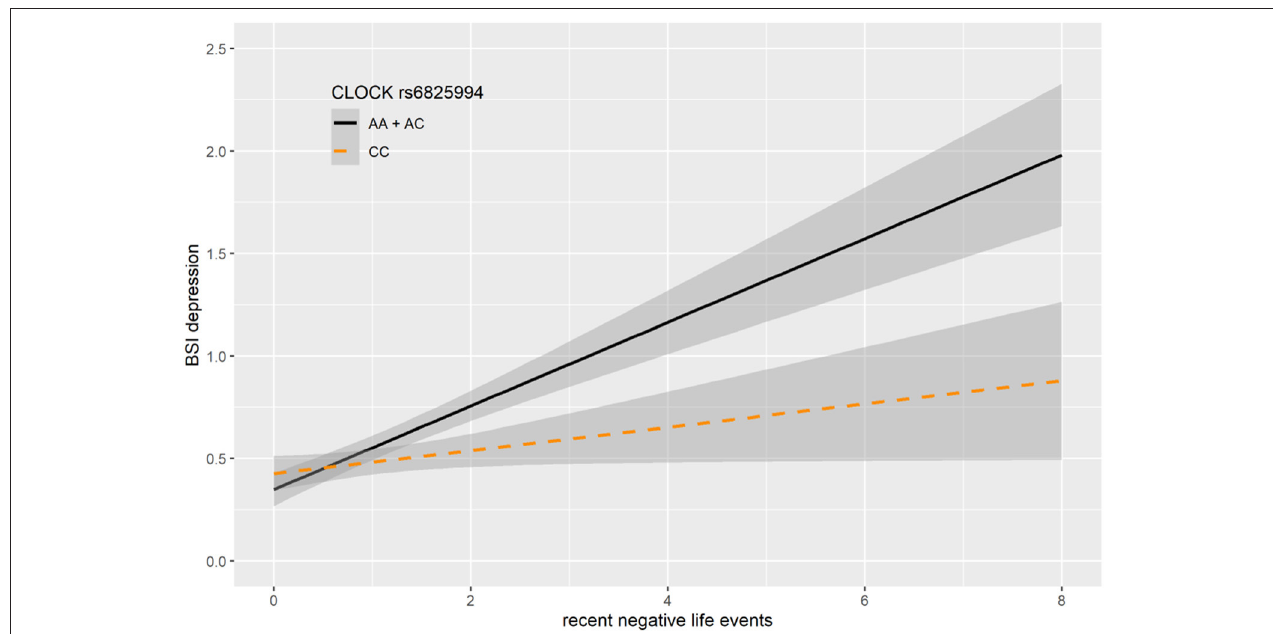
FIGURE 2 | Linear regression indicated a significant interaction between top SNPs rs6825994 of a clump containing 94 SNPs in the CLOCK gene and exposure to recent life events (RLE) on current depressive symptoms (BSI-Dep) in the dominant model, with the minor A allele as a risk allele. Linear regression indicated a significant interaction between CLOCK rs6825994 genotype and recent stressful life events (RLE) on current depression scores according to the dominant ( p = 0.0004, FDR Q = 0.023, as top SNP) and additive ( p = 0.0017, FDR Q = 0.015) models. Presence of the minor A allele was associated with higher depression scores in subjects exposed to more severe recent life events conveying a risk effect. On the vertical axis weighted depression (BSI-Dep) scores are shown. The horizontal axis shows recent life events (RLE) occurring within the past year as measured by the List of Threatening Experiences ( 31). BSI-Brief symptom inventory. Gray shading denotes